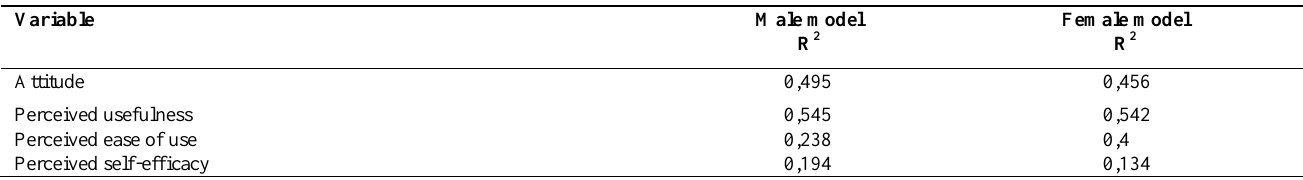
Table 6: Variance explained in dependent variables